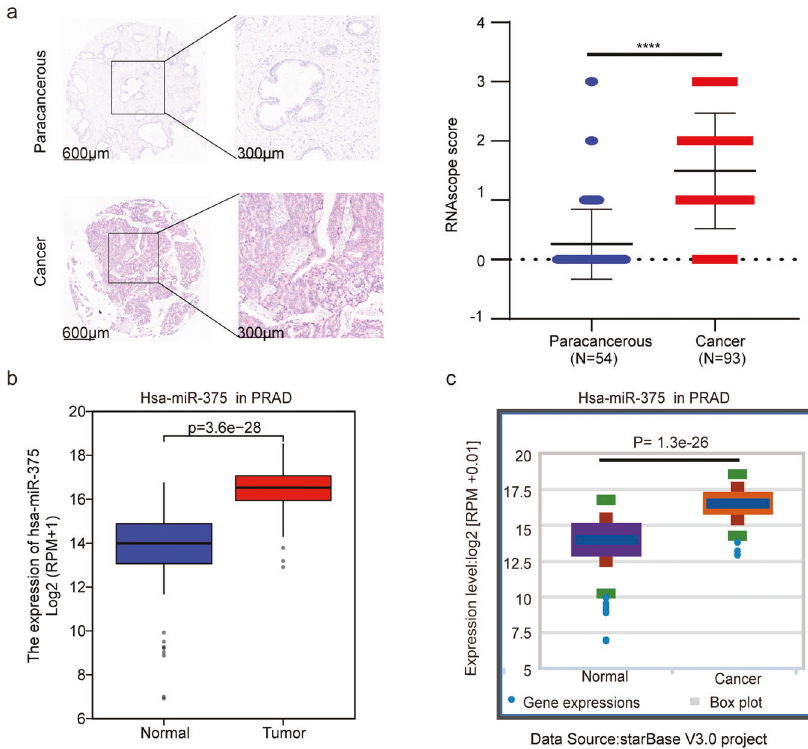
Fig. 1 MiR-375 level in PCa. a Representative images of RNAscope technology for miR-375 in paracancerous and cancer tissues. The red dots indicate the target molecules (left). Statistical analysis of the RNAscope scores (right). MiR-375 expression in PCa from the TCGA ( b ) and the StarBase database ( c ). PRAD prostate